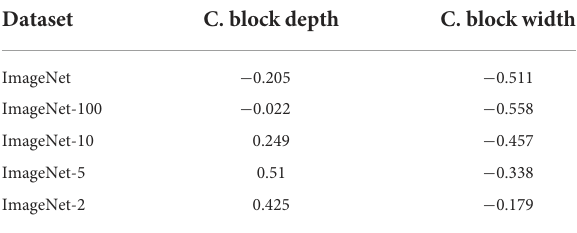
TABLE 4 Correlation of observed error rates with the cumulative block depth and width parameters for all ImageNet-X